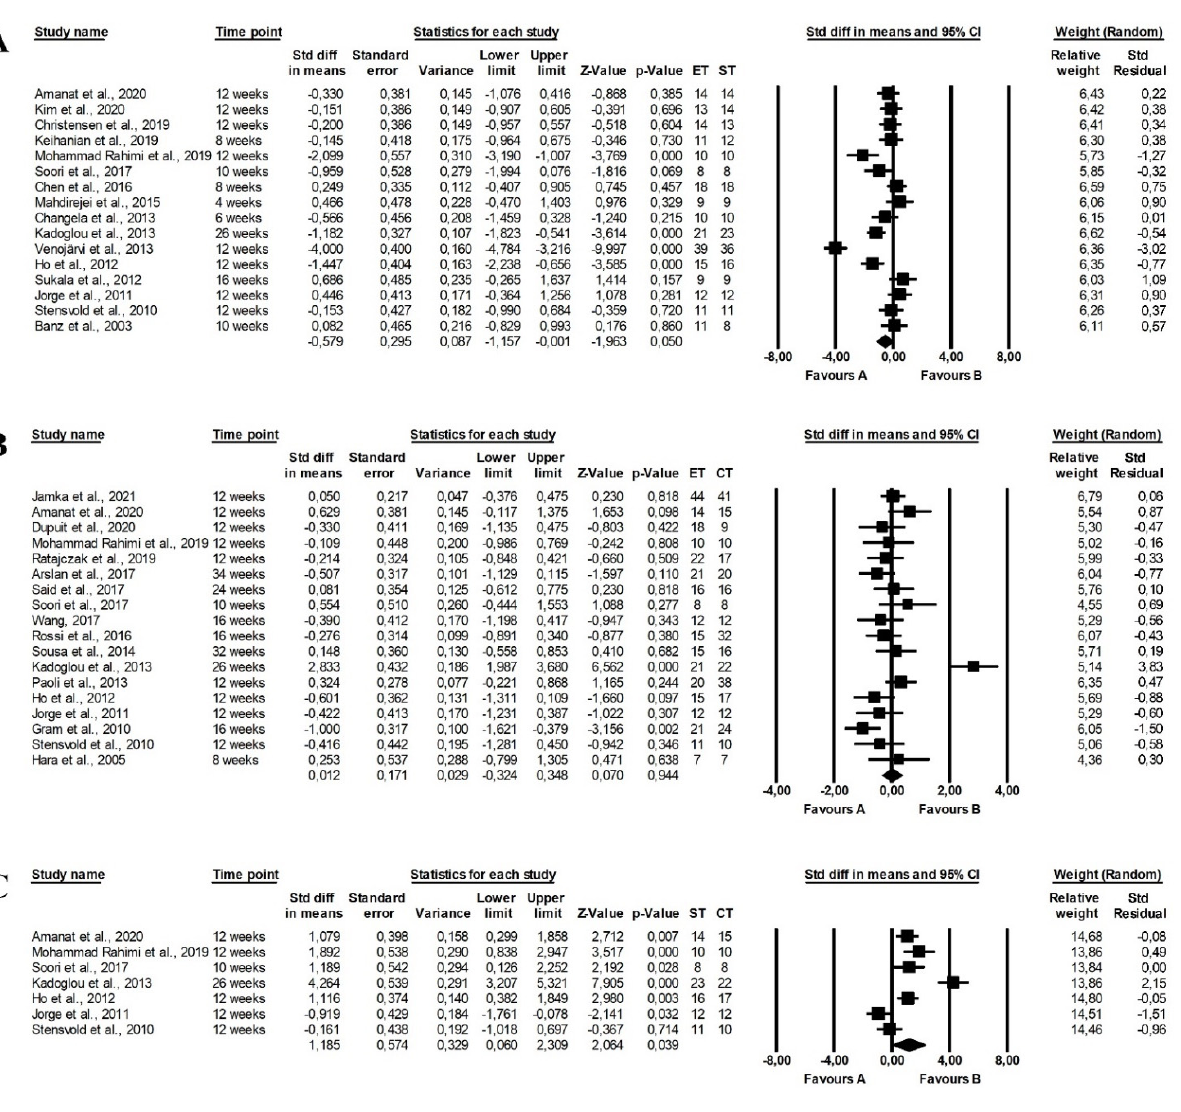
CI—confidence interval; CT—combined training; ET—endurance training; ST—strength training; Std—standard; Std diff—standard differences.